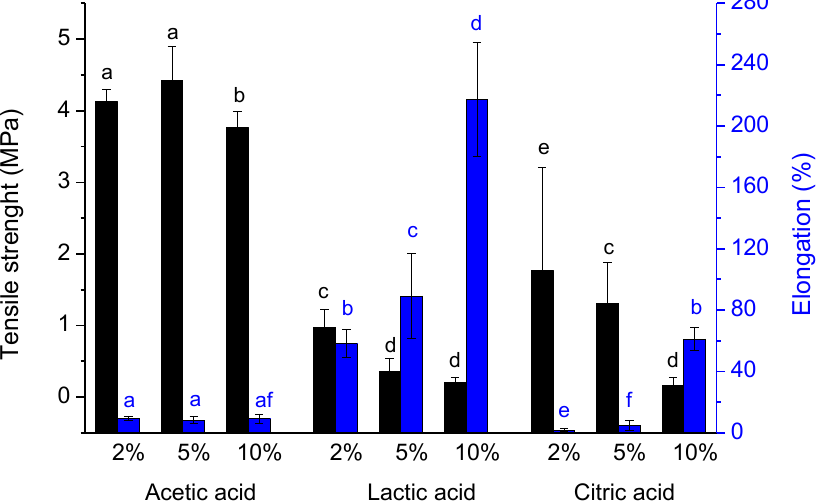
Figure 5. Tensile strength and elongation of chitosan films formed from 1.5% ( w / w ) chitosan solution containing different percentages of acetic, lactic, and citric acid. Data points with different letters are significantly different ( p < 0.05) from each other. The error bars consist of the standard deviation obtained from six repetitions.